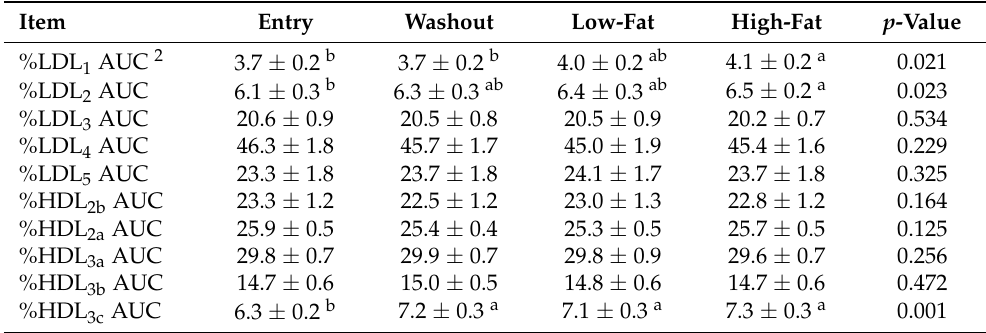
Figure 4. Absolute change (final – entry) in triglyceride and lipoprotein cholesterol following consumption of ground beef patties initially containing 6 g fat/patty (Low fat) and 27 g fat/patty (High fat). TG, triglyceride; TC, total cholesterol; HDL-C, HDL cholesterol; LDL-C, LDL cholesterol. Bars are means ( n = 25) with pooled SEM attached. Change statistically different from 0, * p ≤ 0.05; ** p ≤ 0.01; *** p ≤ 0.001. Table 5. Percent area under the curve for lipoprotein fractions for men at entry and after consumption of ground beef patties initially containing 6 g fat/patty (Low-fat) and 27 g fat/patty (High-fat) 1